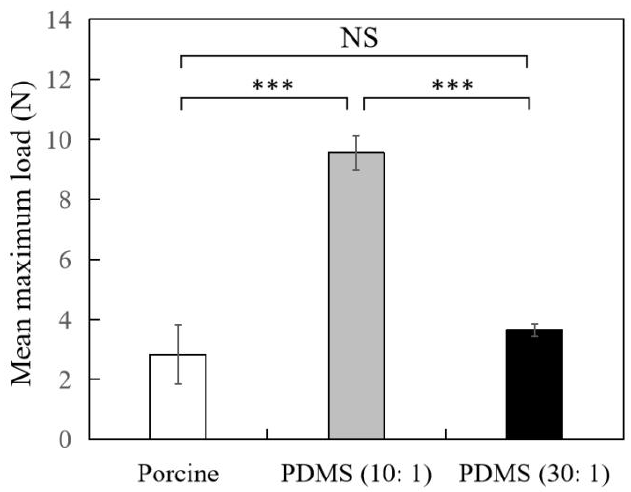
Figure 2. This is an example of a graphic showing the result of the pull-out test. The force is increasing during the pull-out procedure when the barbs hold the specimen. When the barbs fail, the force drops off (blue arrow), and the force of this point is defined as “maximum load”; the moving distance is “displacement of maximum load”.